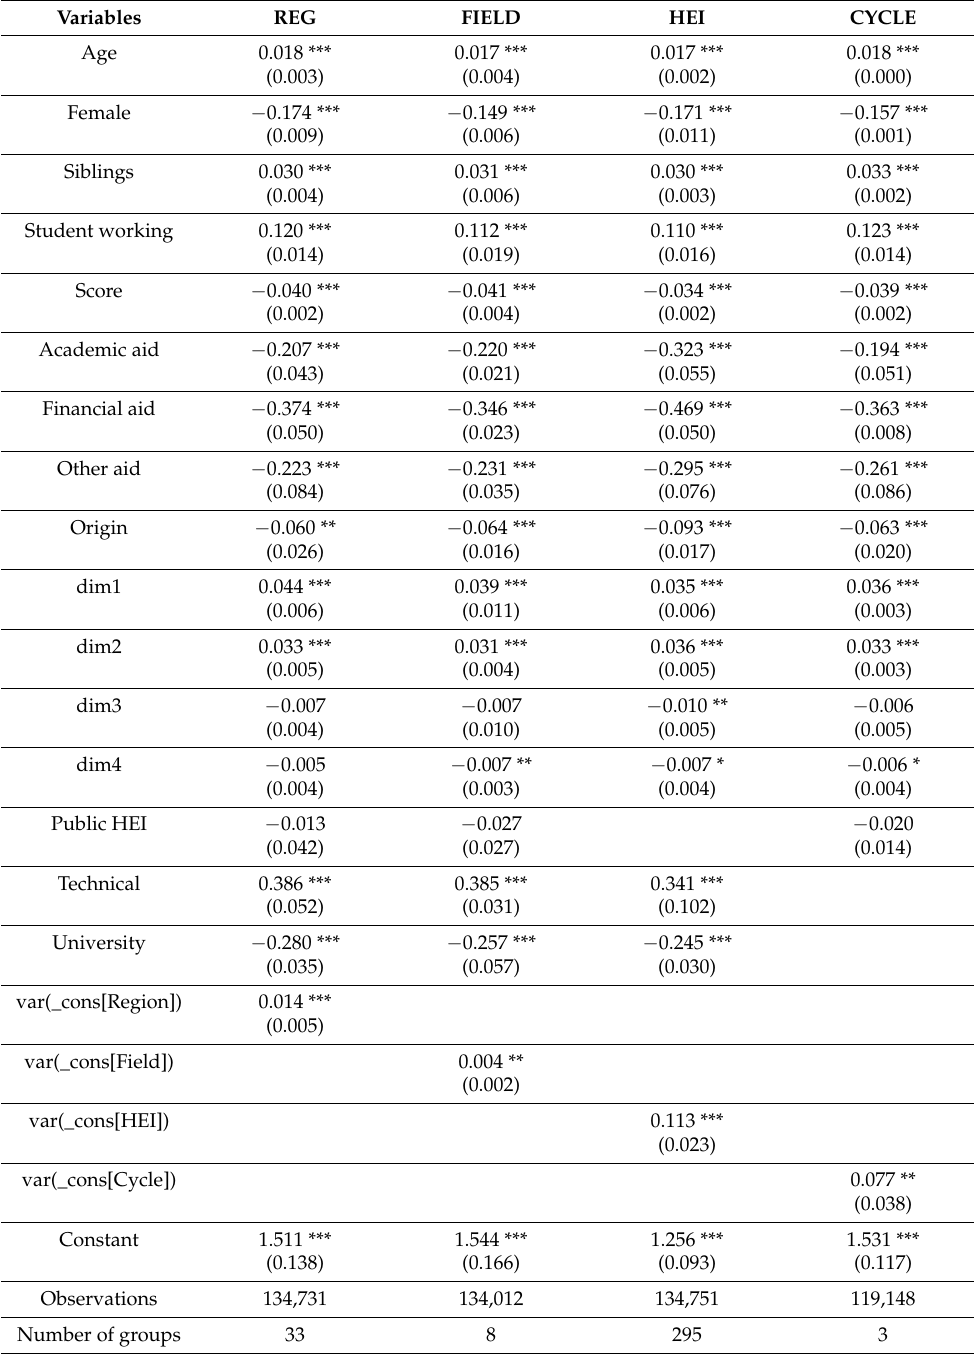
Table 5. Dropout estimation results (two